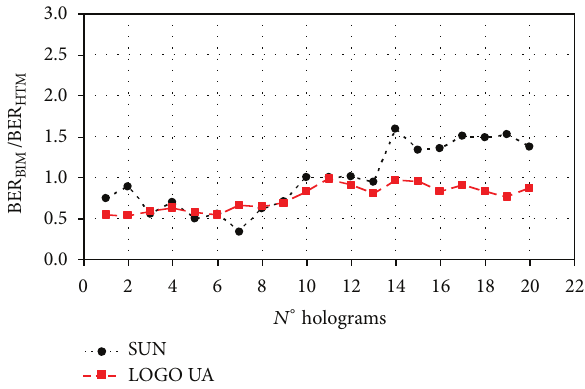
Figure 6: Relative values of the BER between the BIM and HTM for the objects of SUN and LOGO